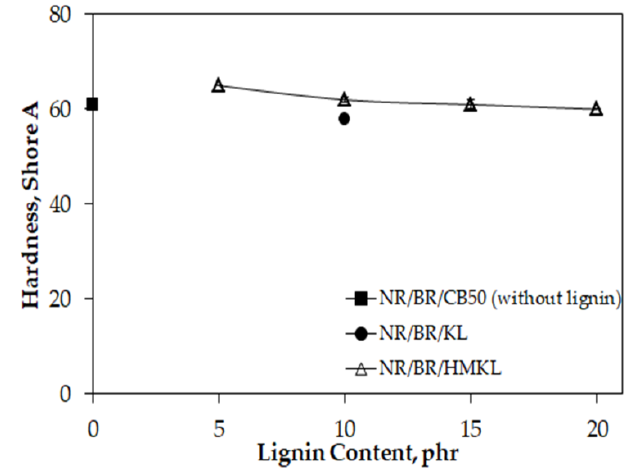
Figure 10. The effect of HMKL content on the hardness of lignin-filled NR/BR compounds. Figure 10. The e ff ect of HMKL content on the hardness of lignin-filled NR / BR